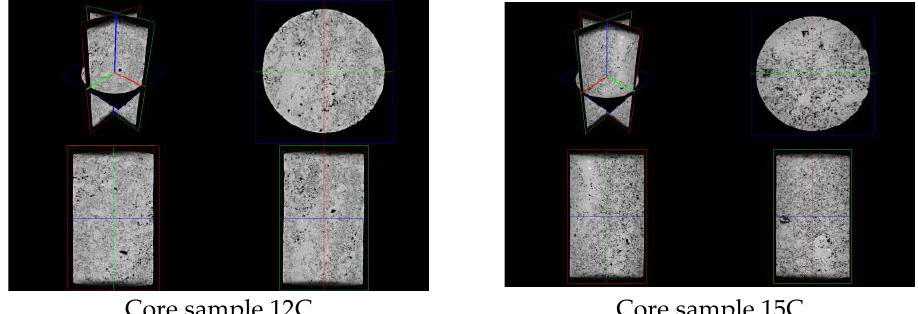
Figure 5. Three-dimensional visualization of the void space shape. Table 10. Material balance in the filtration experiments.